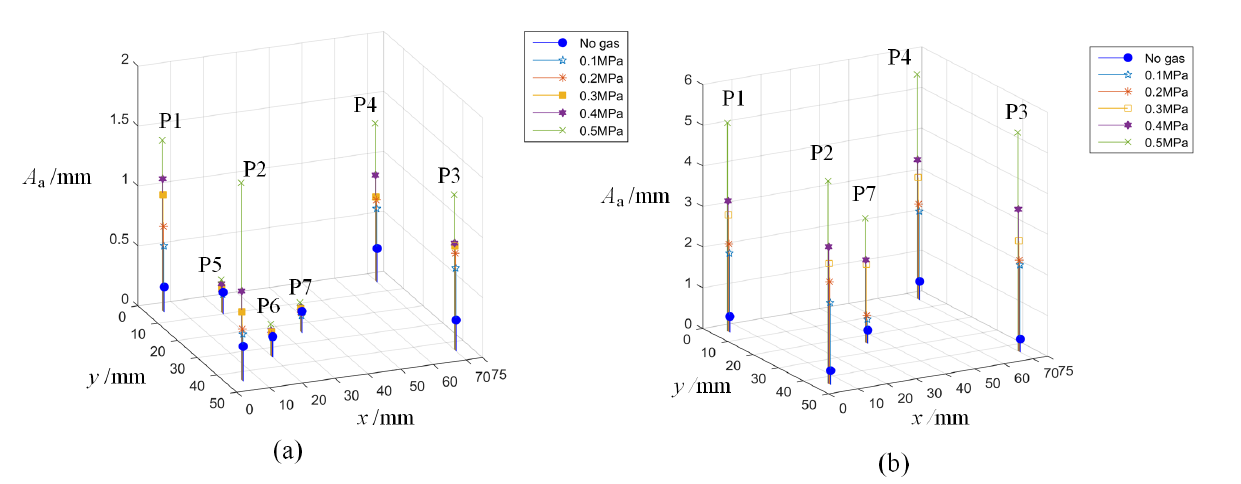
Figure 9. Time-average amplitude Aa under different air-supply pressures: ( a ) double-ring-grooved; and ( b ) double-U- grooved.